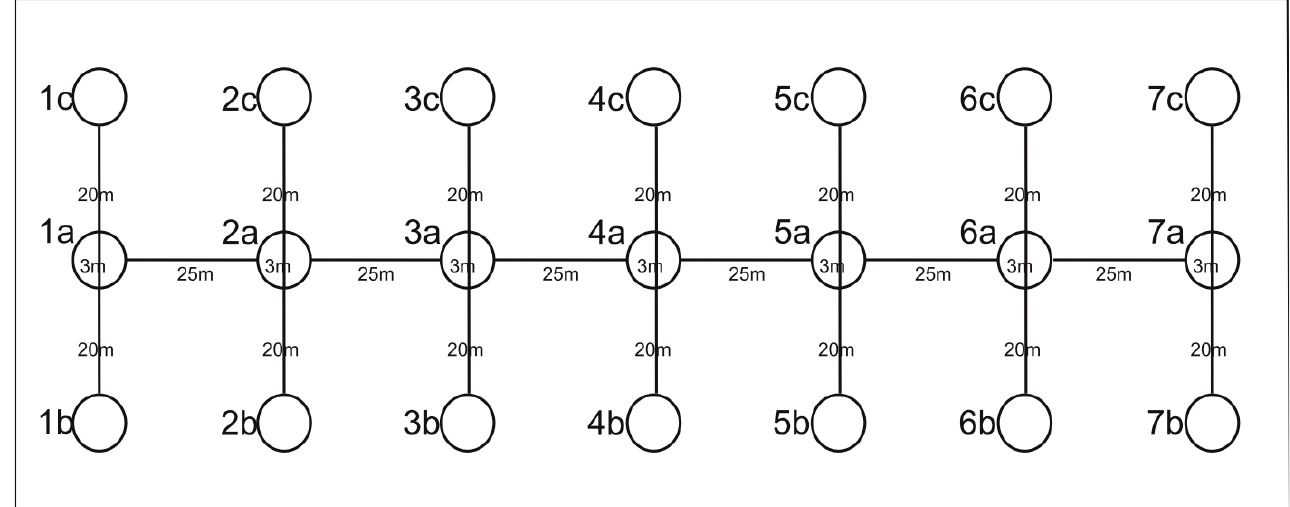
Figure 1. Principal sampling scheme of each of the five investigated broadleaved tree species. Juvenile trees were sampled in circular sampling plots, numbered from 1a to 7c (hollow circles).